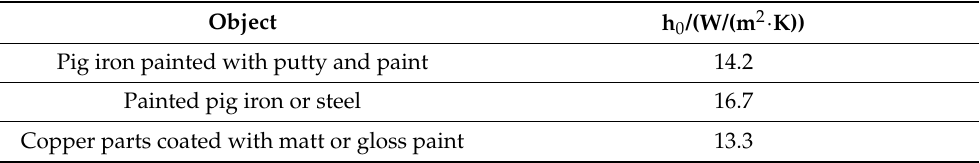
Table 2. Surface heat transfer coefficient of different surface characteristics.